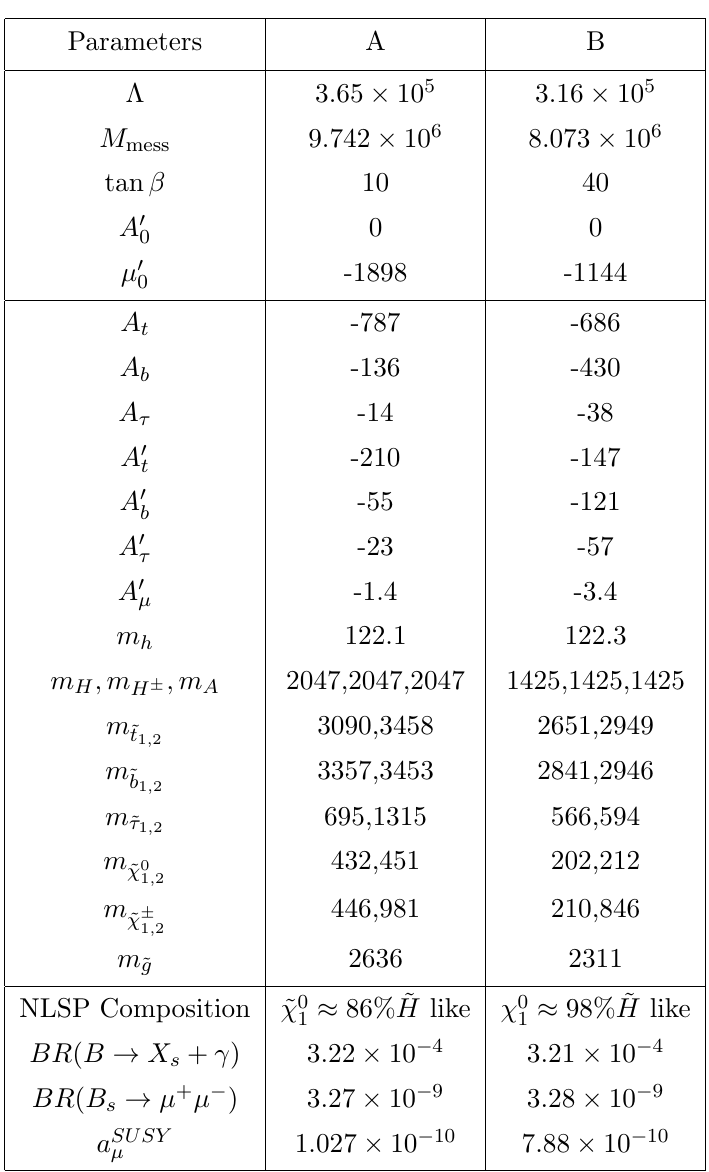
Table 1 . Representative Points for NHmGMSB: all the dimensional parameters are in GeV.